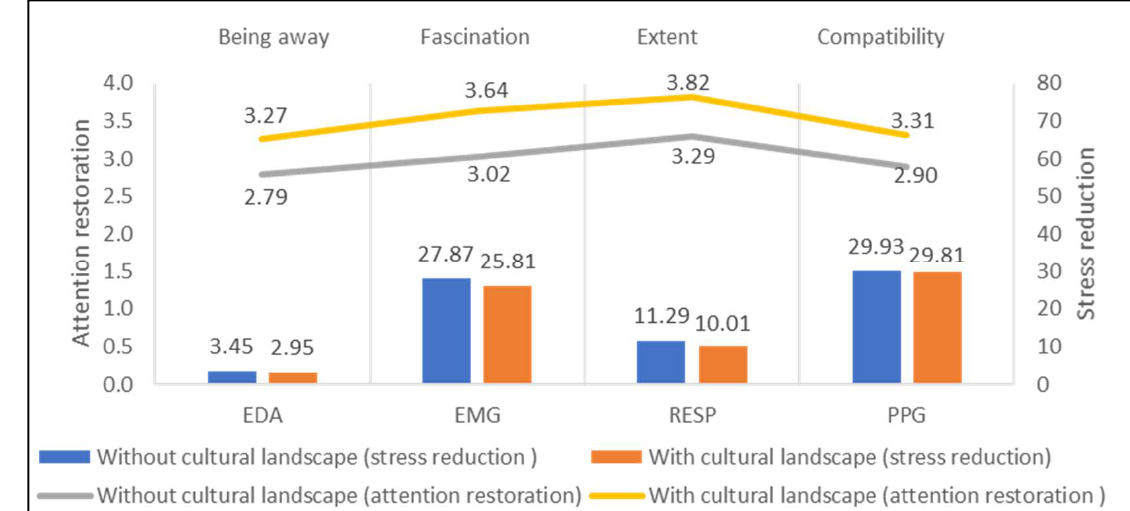
Figure 9. Impacts of cultural landscape on stress recovery and attention restoration.